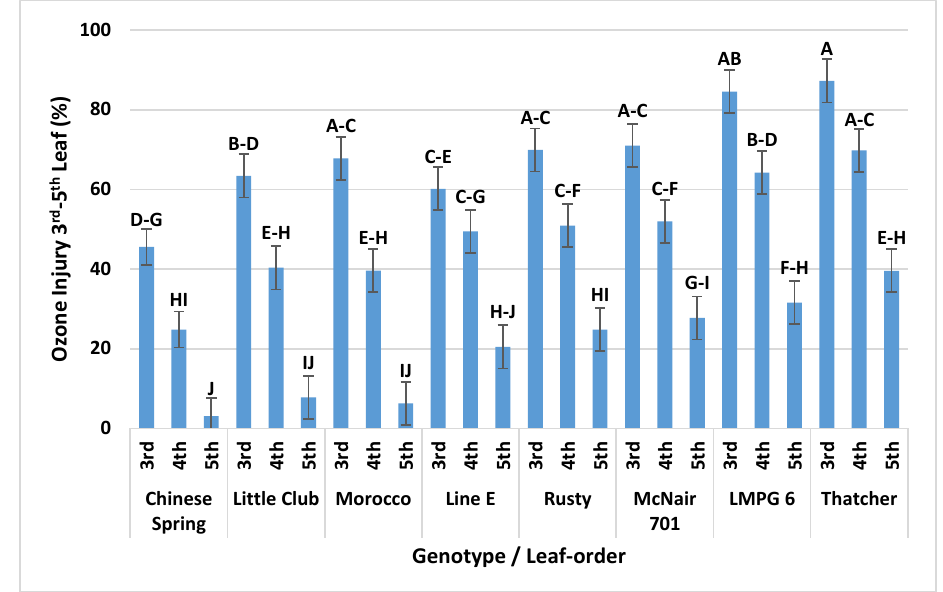
Figure 9. Interplay of leaf-order (third – fifth leaf) and genotype on average O 3 injury (±SE) of rust near-universal susceptible genotypes, exposed to O 3 (50, 70, 90 ppb) for 14 days (12 h/day), at 25 °C and 50% RH, in OPECs. Injury was visually estimated, under constant light conditions on a 0 – 100% scale. Values are means (±SE) statistically separated using Tukey-Kramer adjustment for multiple comparisons. Means marked with the same letter are not significantly different at α = 0.05.